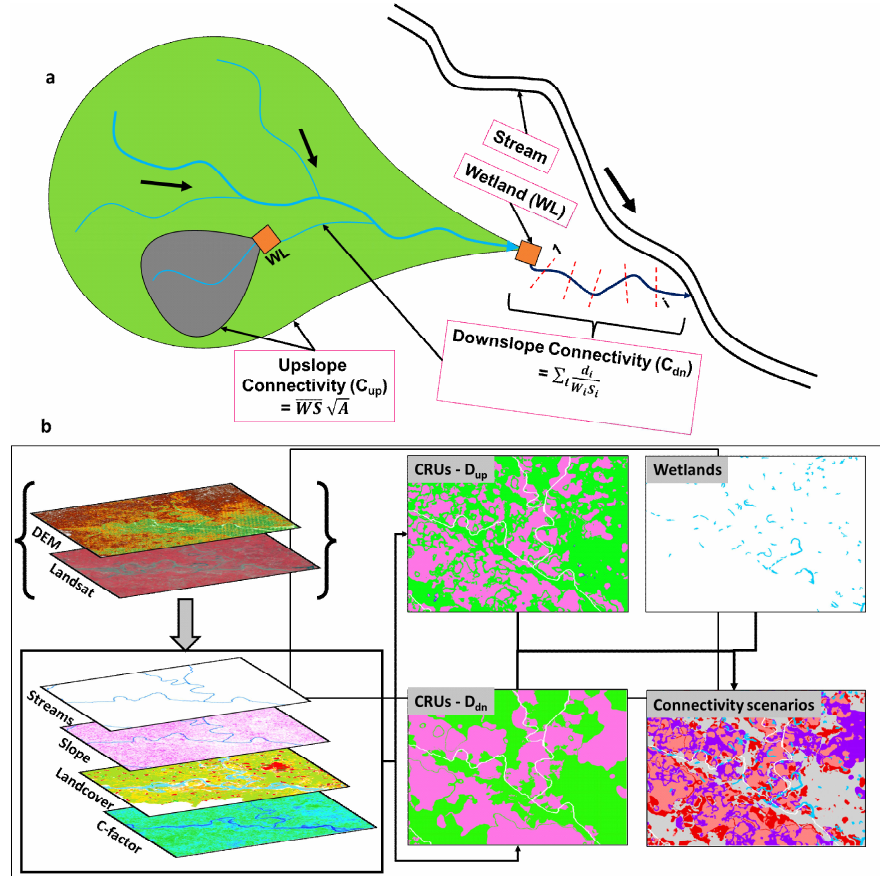
Figure 3. ( a ) Wetlands and their nested connectivity scenario from upslope and downslope connectivity response units (CRUs) in an alluvial setting. ( b ) The CRUs are a resultant of underlying properties of a landscape such as topography and landcover which dictate the surface flows.